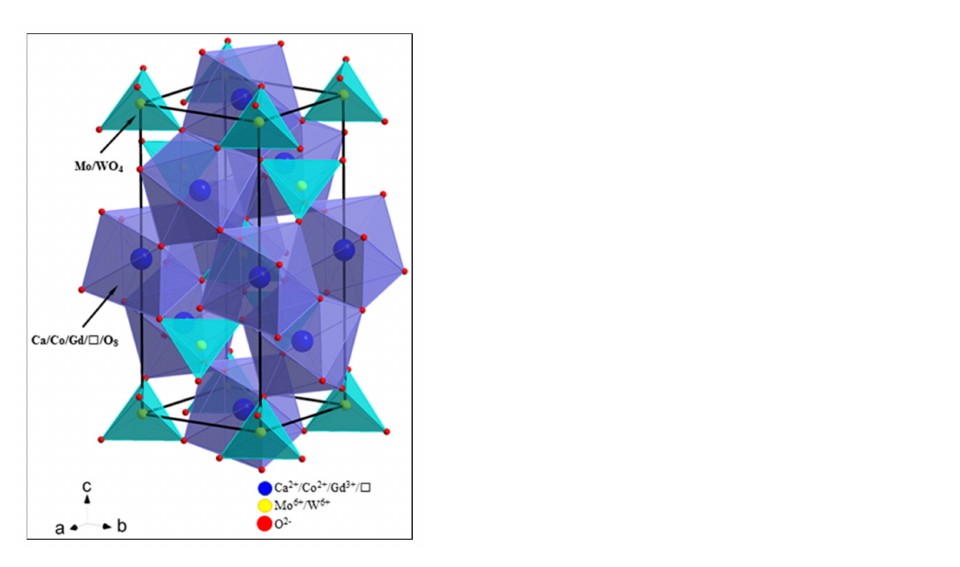
Figure 3. Visualization of the scheelite-type structure of the CCGMWO solid solution. Leg- end: navy balls—Ca 2+ /Co 2+ /Gd 3+ / ; yellow balls—Mo(W) 6+ ; red balls—O 2 − ; and a, b, and c— crystallographic